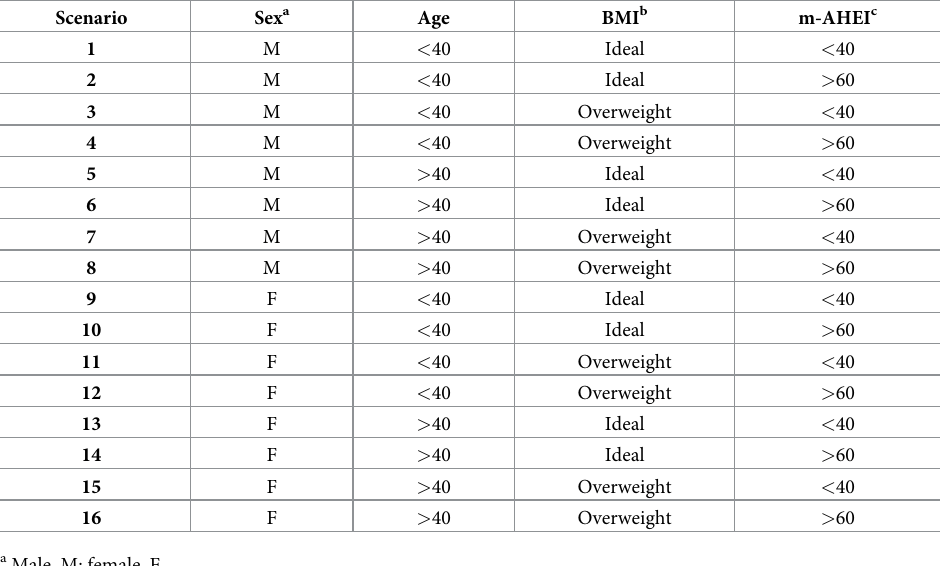
Table 1. Characteristics of subjects presented to nutrition professionals according to